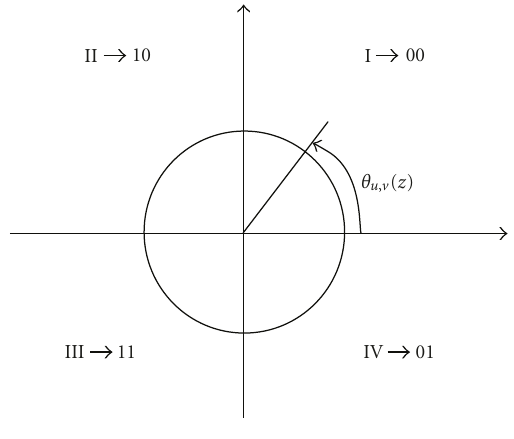
Figure 1: Quadrant bit